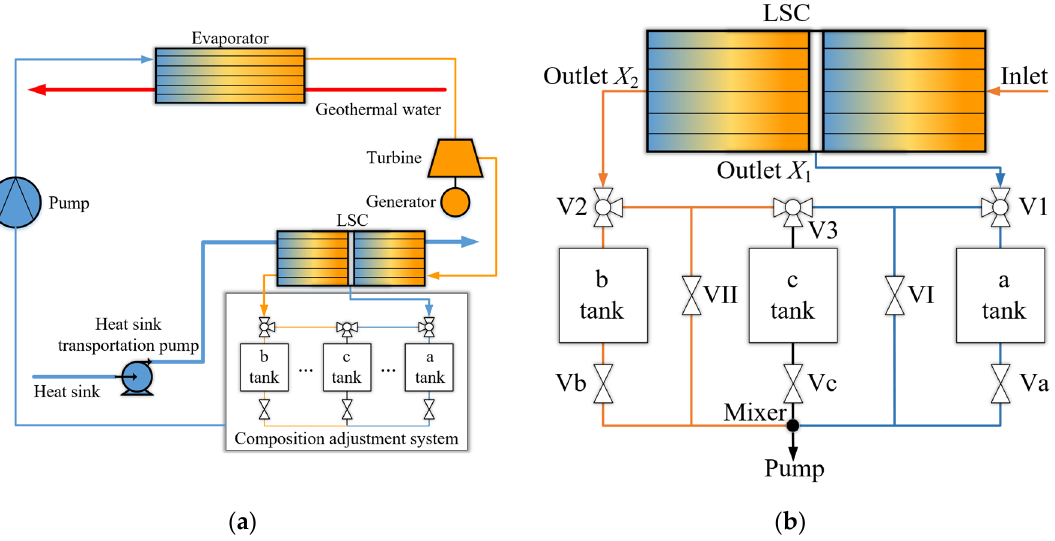
Figure 12. ( a ) Schematic of LCAZORC; and ( b ) representation of a three-tank LSC-based composi- tion regulation system [69]. Reproduced with permission from Lu et al., Energy Conversion and Man-agement; published by Elsevier, 2020.